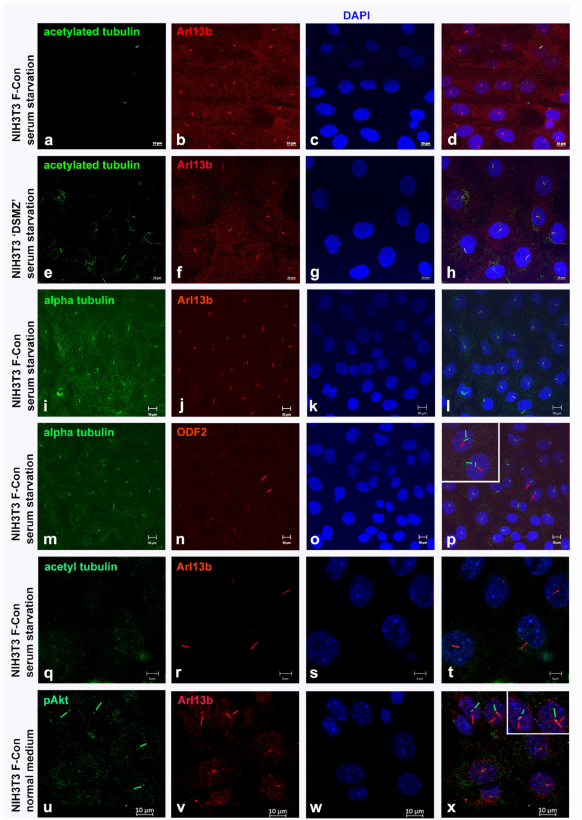
Figure 8. Arl13b is a reliable marker for primary cilia. In the NIH3T3 sub-cell line, F-con only a few of the primary cilia detected by Arl13b-staining are also decorated for acetylated tubulin ( a – d ), whereas all primary cilia in the newly obtained sub-cell line from DSMZ (NIH3T3 “DSMZ”) contain both, acetylated tubulin and Arl13b ( e – h ). Arl13b-positive structures in NIH3T3 F-con comprise an axoneme, by detection of α -tubulin ( i – l ), and a basal body, decorated by ODF2 ( m – p ; pink arrows depict ODF2-decorated basal bodies highlighted in red in ( n , p ). Enlargement of two cells with primary cilia in subfigure ( p ).). Primary cilia in NIH3T3 F-con cells are functional signal transducers by demonstrating the activated AKT-kinase (pAKT) at the basal bodies ( u – x ; pAKT signals at the base of the primary cilia are decorated in green and are depicted by light green arrows in u and x. The primary cilia are stained in red and are depicted by pink arrows in v and x. Enlargement of two cells with primary cilia in ( x )). Even basal bodies are not enriched for acetylated tubulin in NIH3T3 F-con ( q – t ). Bars: 5 µ m ( q – t ), and 10 µ m (all other